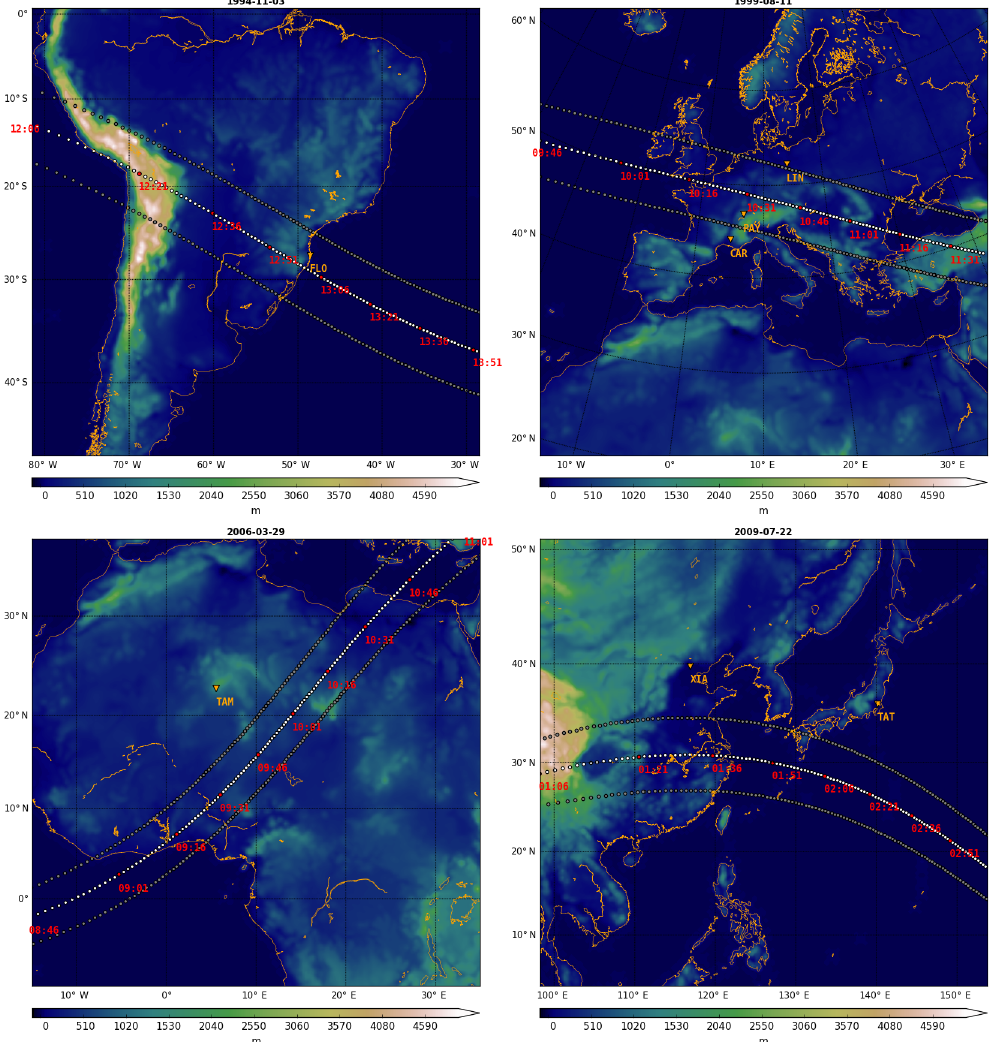
Figure 2. Domains used for each case study. Sites are indicated in orange. The eclipse track is represented by the central gray points. The red points indicate some of the eclipse times in UTC. The dark gray points show the bounds of the 90%